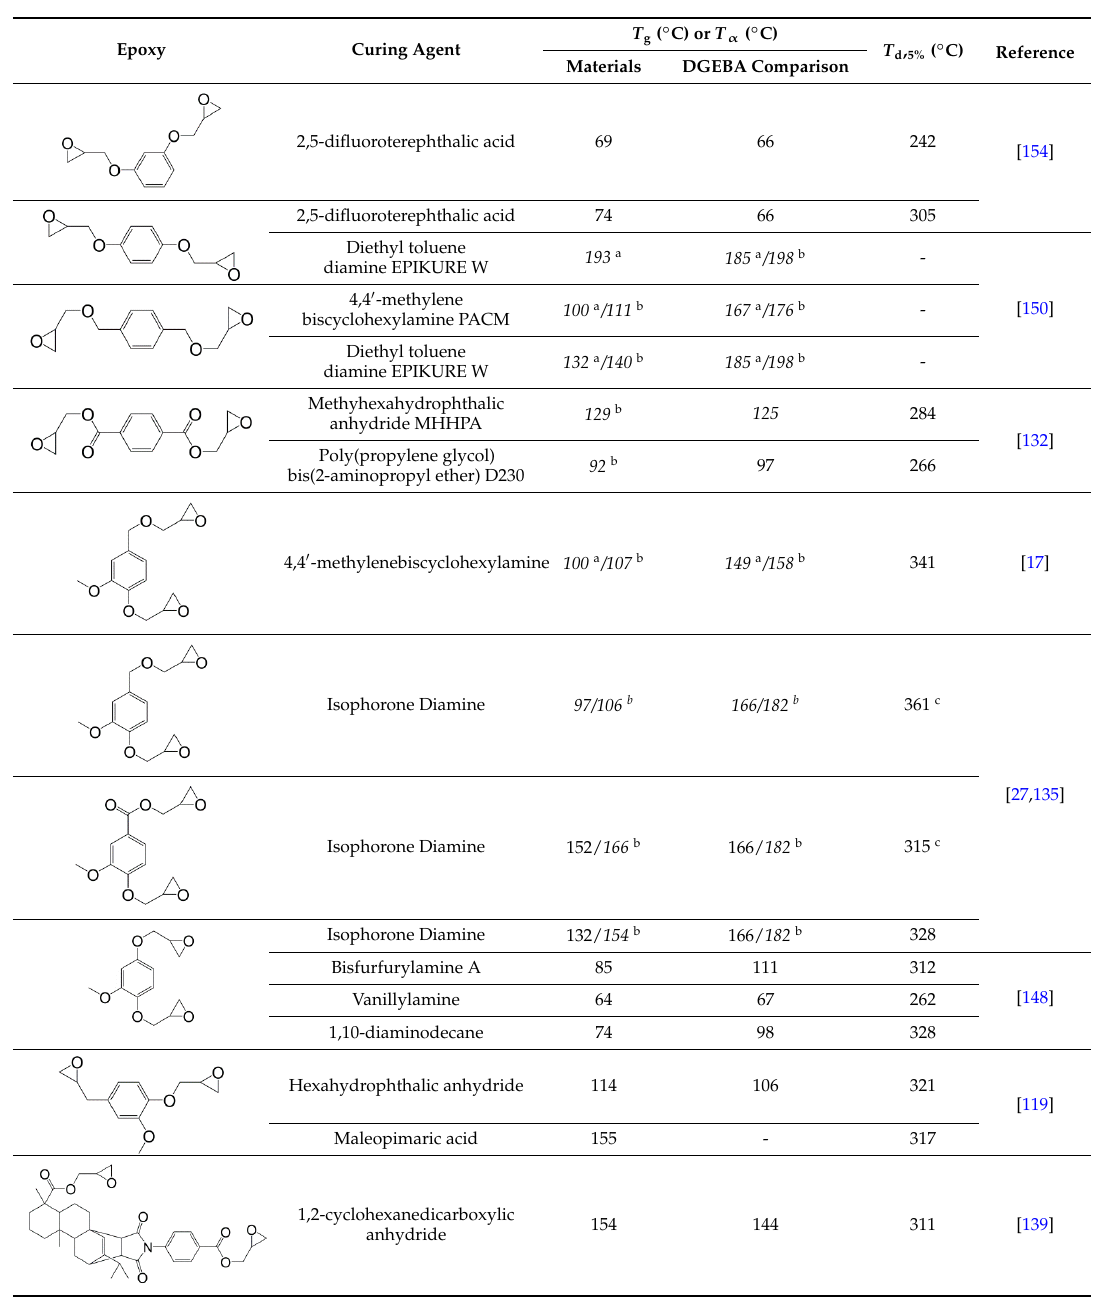
Table 1. Mono-aromatic, di-epoxy monomers and thermal properties of the cured materials. T g values are indicated in plain text, T α are in italics.